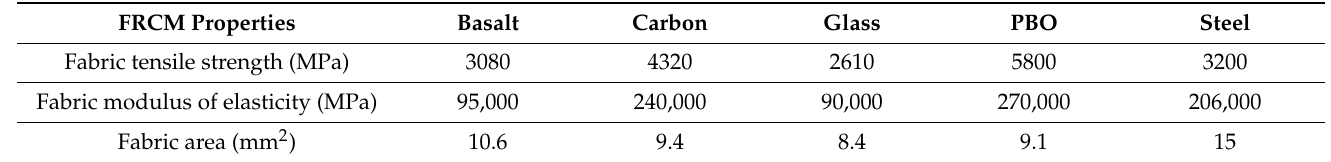
Table 2. Fabrics and cementitious matrix